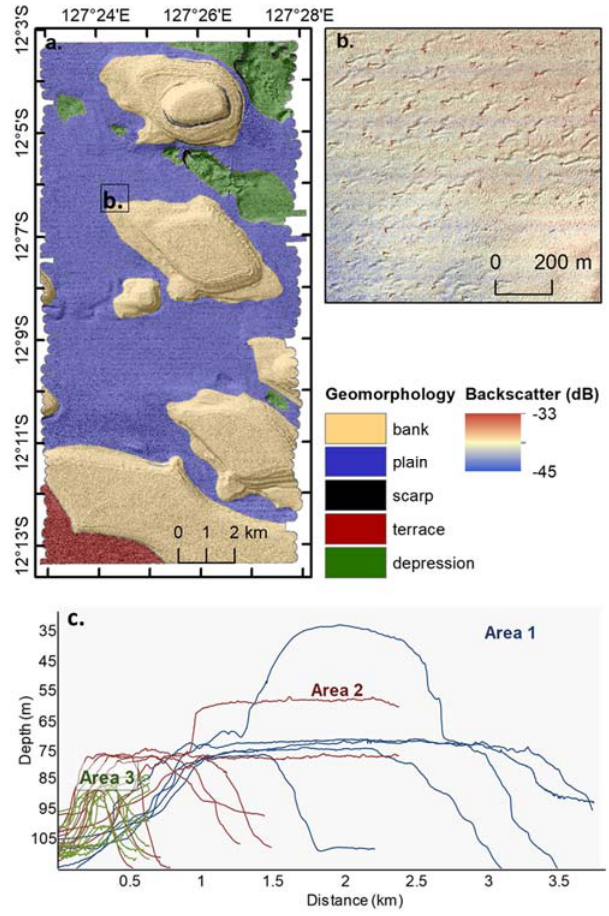
Figure 3. ( a ) Geomorphic map of Area 1. ( b ) Hillshaded backscatter inset showing scoured pockmarks with high backscatter intensity centers (red). ( c ) Bank profiles taken along the narrow axis of all banks in the study area. Colours are associated with the area in which the bank was profiled.